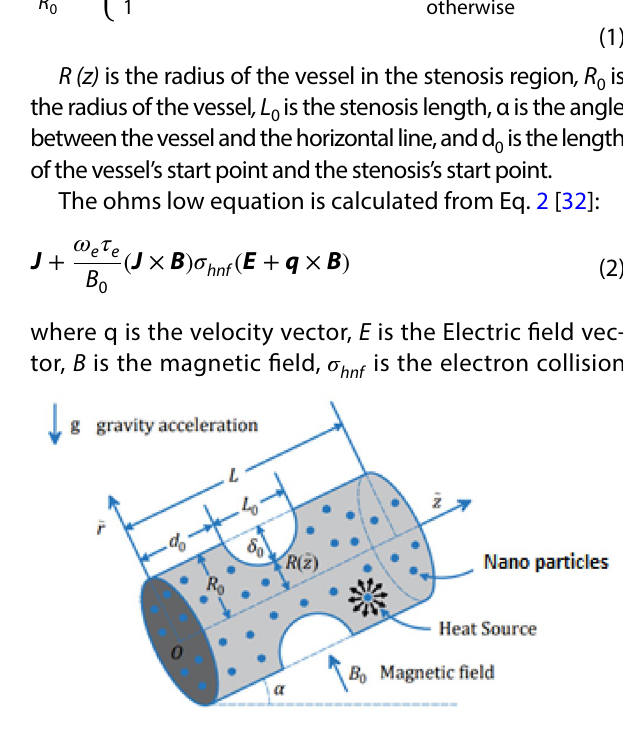
Fig. 1 The geometry of the